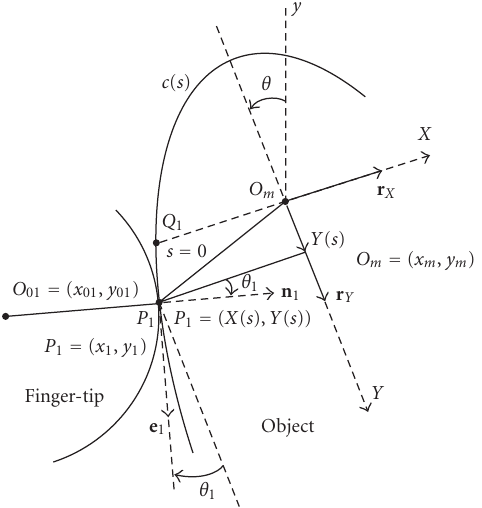
Figure 7: Definitions of physical symbols in relation to rolling contact. θ 1 denotes θ 1 ( s ) appearing in